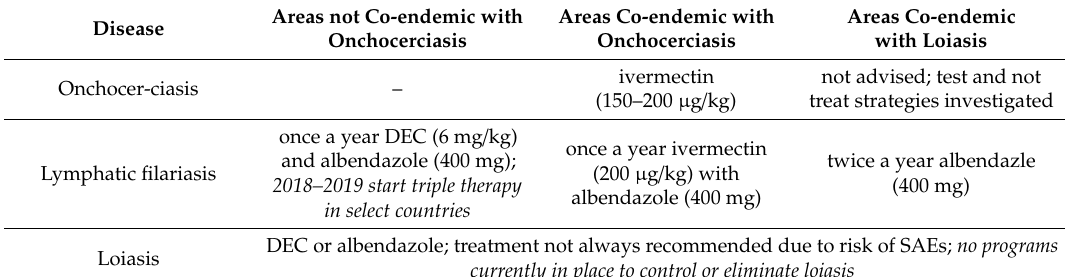
Table 3. Guidelines for treatment of filarial parasite infections through preventive chemotherapy mass drug administration